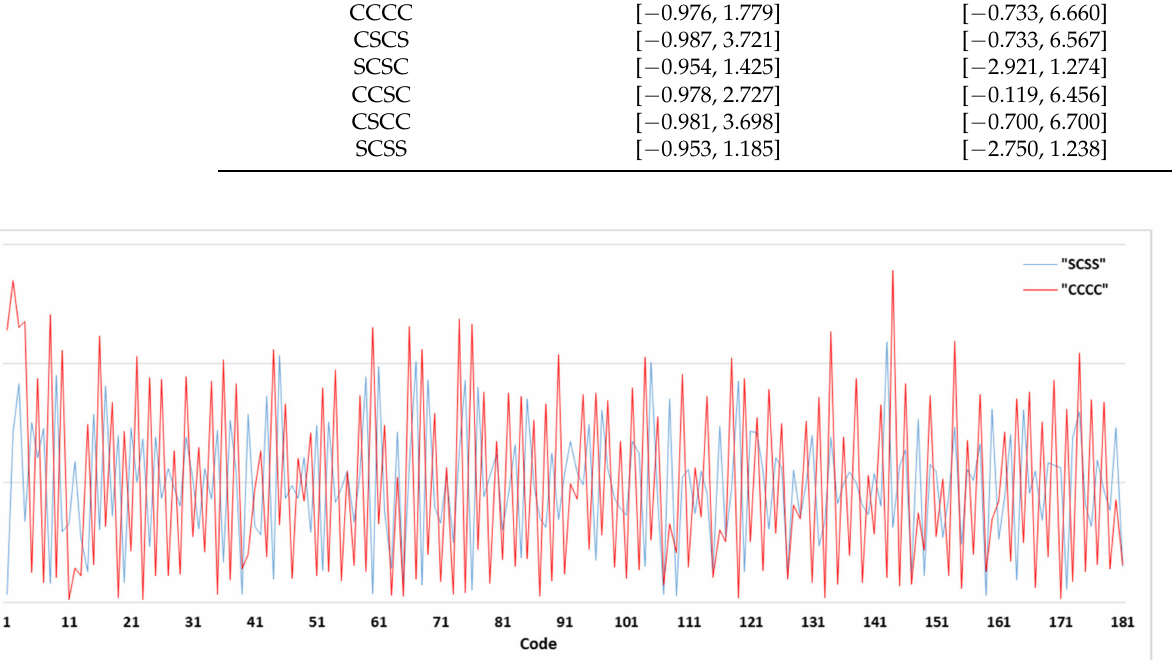
Figure 6. DNL results of “SCSS” and “CCCC” sampling patterns.